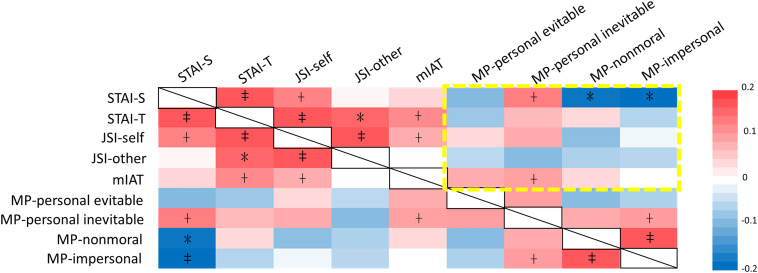
Significance plot of the intercorrelations among dispositional measures of anxiety, justice sensitivity, implicit moral attitudes, and moral permissibility. State anxiety was positively correlated with the permissibility of inevitable harm, but negatively correlated with non-moral and impersonal harm. Implicit moral attitude (mIAT) was positively correlated with the permissibility of inevitable harm. The colors and color bar values (right) represent the Pearson correlation coefficient (For the exact values, see Supplementary Table 1). STAI, state-trait anxiety inventory; JSI, justice sensitivity inventory; mIAT, moral implicit association test; MP, moral permissibility; + p < 0.1; *p < 0.05; ‡p < 0.001.